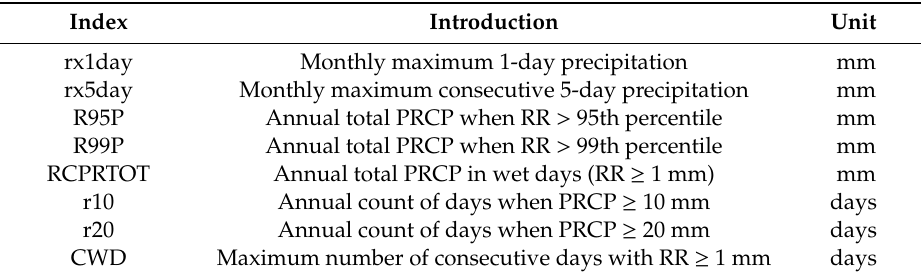
Table 3. Extreme precipitation index